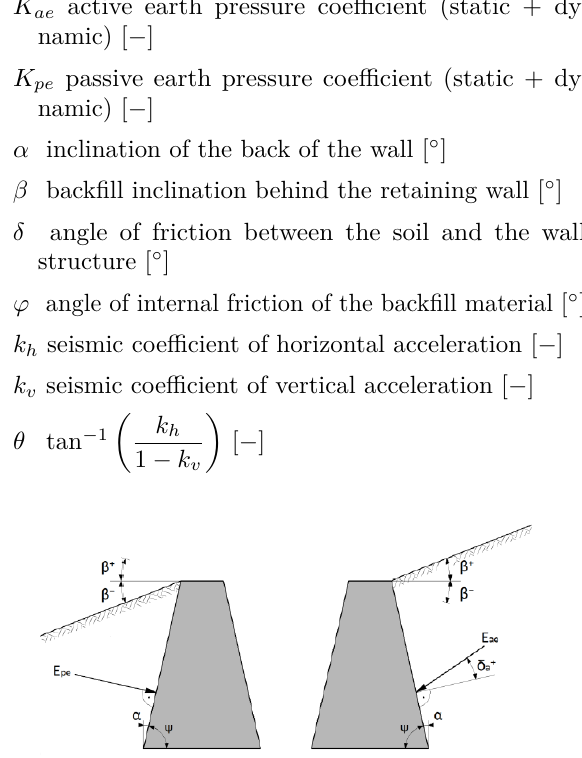
Figure 2. Sign convention (left: passive, right: